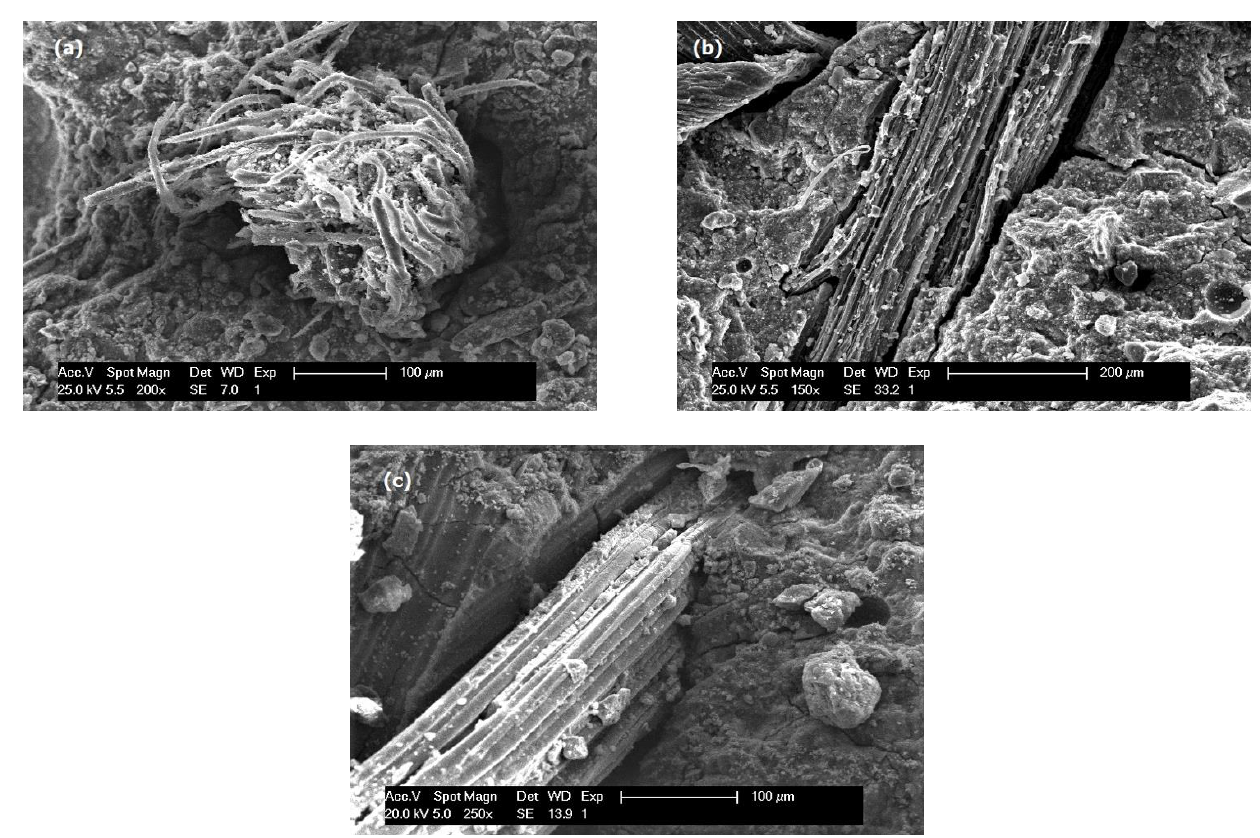
Figure 6. Morphology of the different fracture surfaces of the composites: ( a ) bamboo, (b ) hemp and ( c ) kenaf. The plot of the applied force vs. the midspan deflection for the reinforced 3 wt% sam- ples is shown in Figure 7. From the completely brittle behavior of the unmodified sample, after fiber addition, the mechanical behavior becomes pseudoplastic. The effect is more intense in the kenaf and hemp samples. Indeed, the average absorbed energy for the spec- imens is reported in Figure 8 as a function of fiber content.